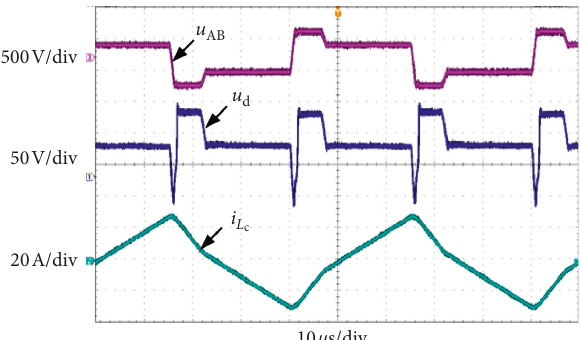
Figure 19: Waveforms of primary and secondary voltages of high- frequency transformer and commutation inductor